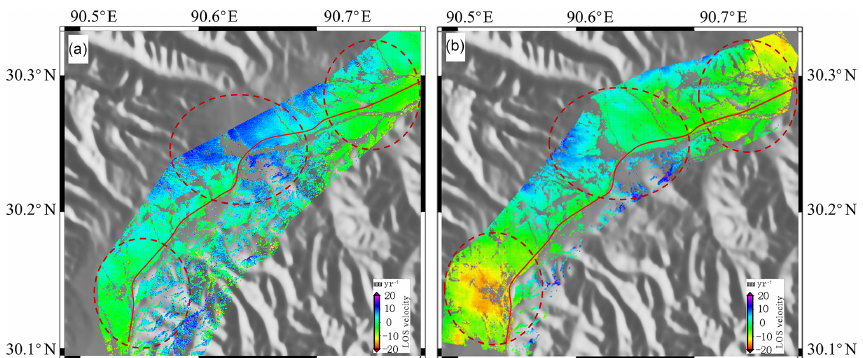
Figure 6. The deformation maps of the overlap area of the TerraSAR-X and ASAR data. (a) The ASAR T405 data range from 2008 to 2010. (b) TerraSAR-X data range from 2011 to 2012.